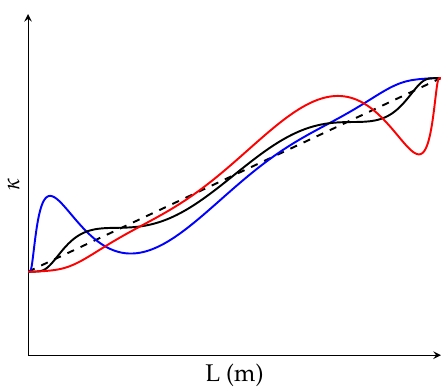
Figure 19. Curvature plots of the clothoid (dashed) and blending splines in [ p 1 , q 1 ] for tightening parameters α , γ = 1,1 (black, default), α , γ = 4,1 (blue), and α , γ = 10,1 (red).